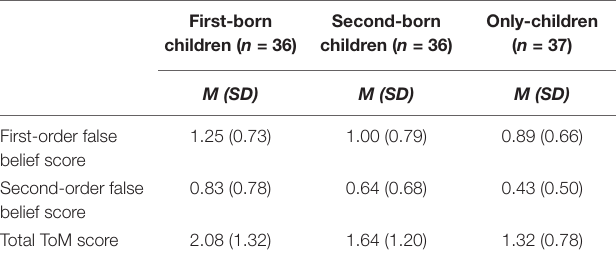
TABLE 1 | Descriptive data about the scores of first-order false belief, second-order false belief and ToM for first-born children, second-born children, and